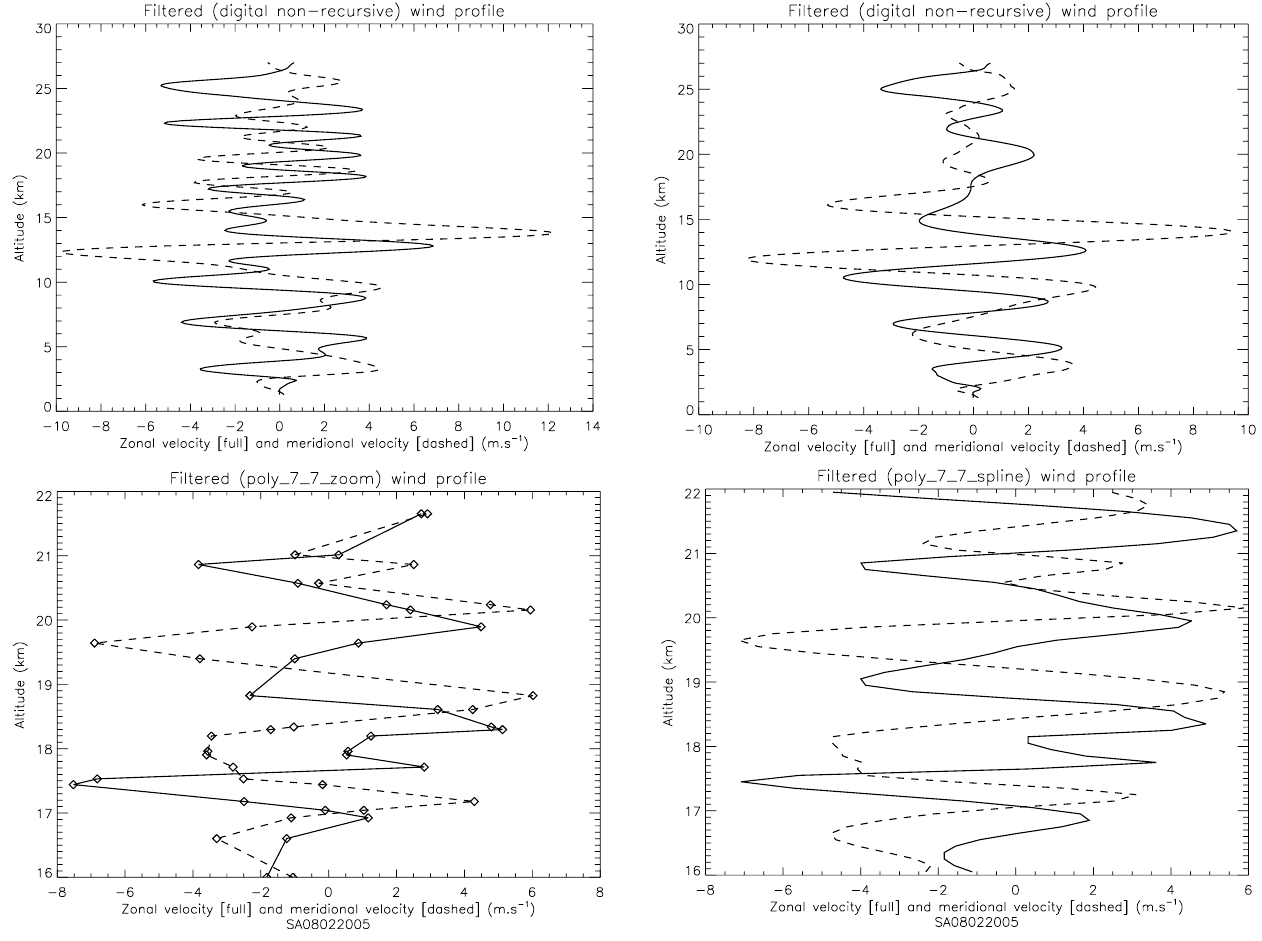
Fig. 10. Case 2: Salta Aero radiosounding. Vertical profiles of velocity perturbations (ms − 1 ). Full line: zonal wind, dashed line: meridional wind. Top-left: Non-recursive digital filter with bandpass window of [1.5, 8]km. Top-right: Non-recursive digital filter with more restrictive bandpass window of [3, 8]km. Bottom-left: 7th-order polynomial filter, with focus on the 16km to 22km altitudes (the filter is however applied to the entire vertical profile) – no cubic spline interpolation. Bottom-right: Same as bottom-left – with cubic spline